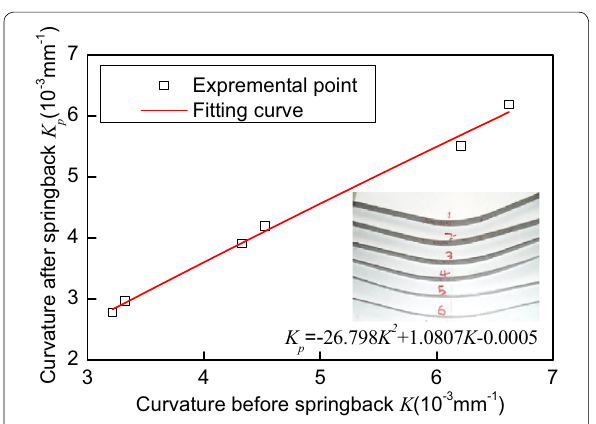
Figure 12 Curvatures of bending parts in stretch-bending before and after springback